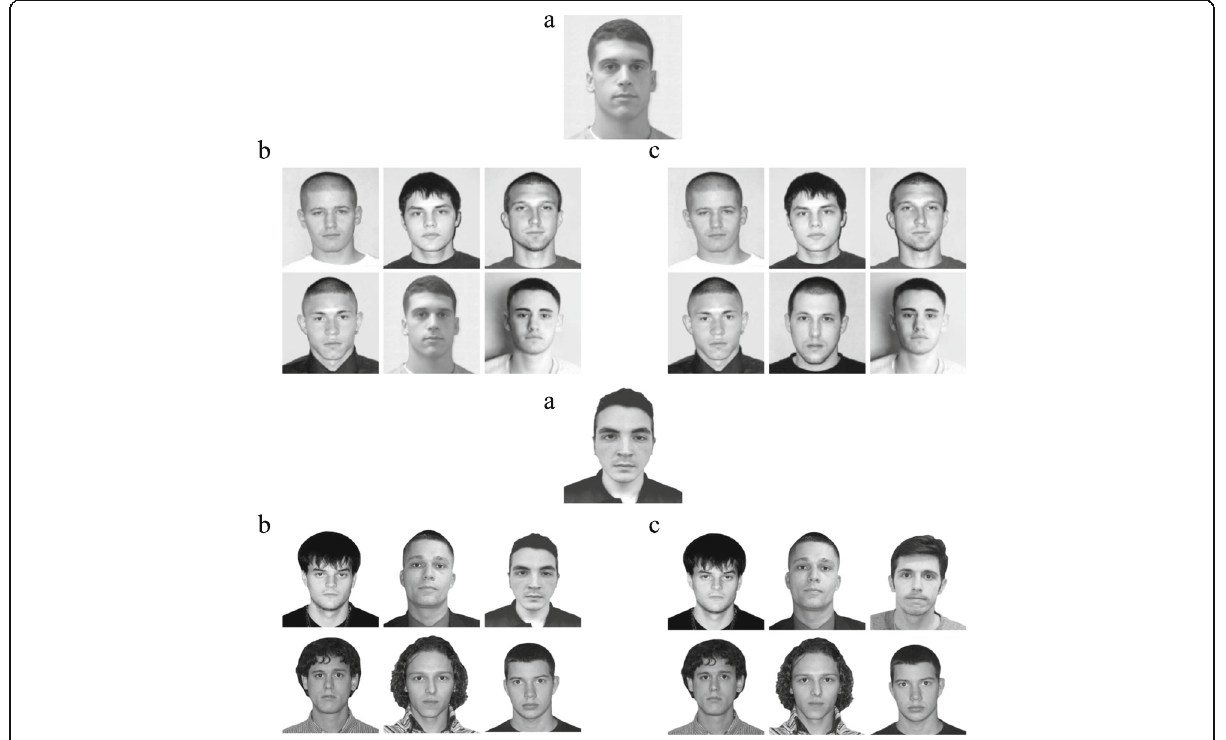
Fig. 1 Set A ( top ) and Set B ( bottom ): ( a ) represents the suspects and ( b ) and ( c ) are the TP and TA lineups,